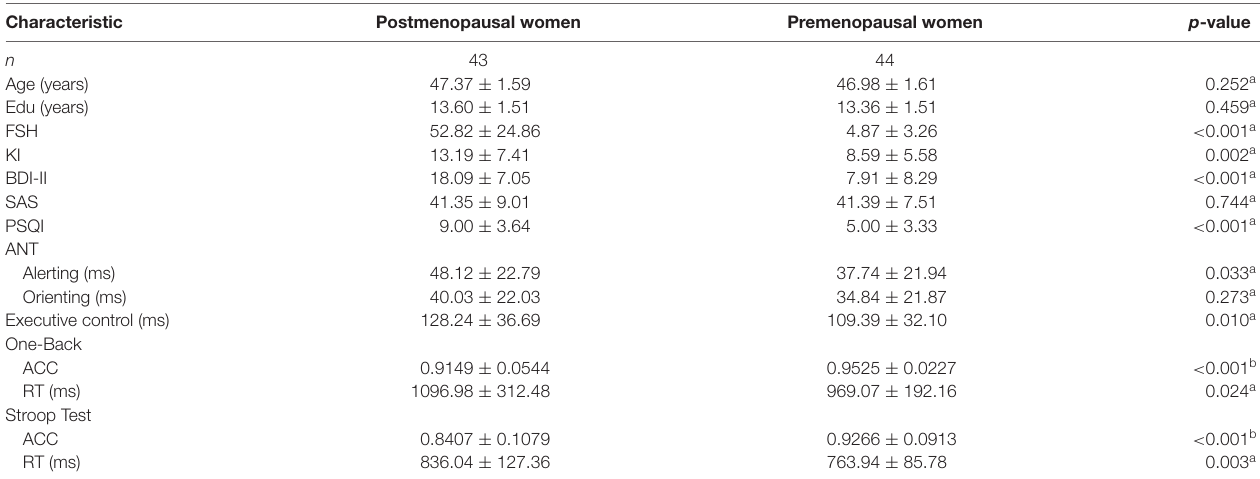
TABLE 1 | Demographic, clinical characteristics, mood and cognitive performance data.